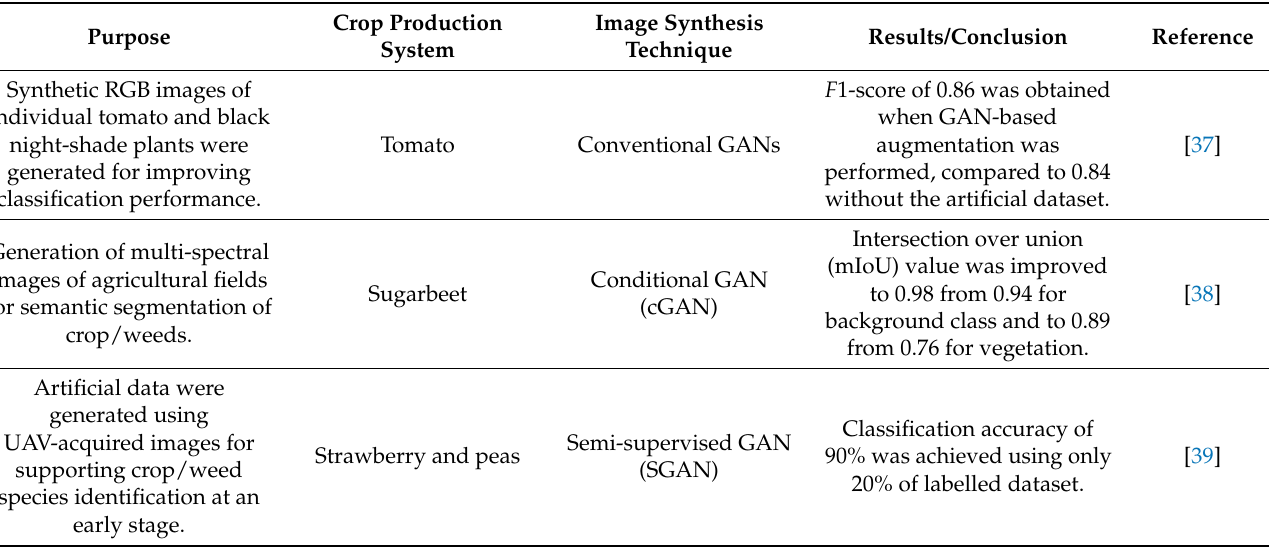
Table 1. Summary of previous studies on the application of GANs for crop/weeds identification